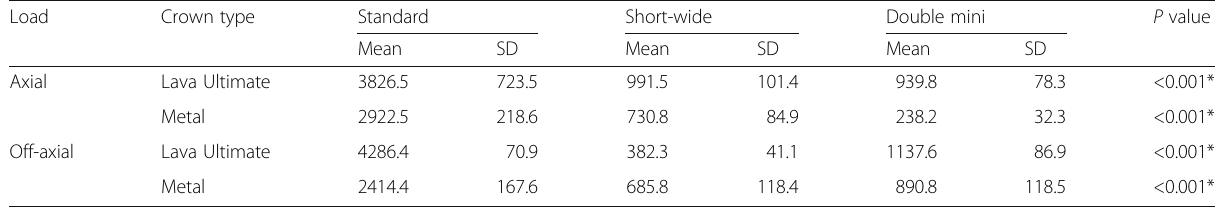
Table 2 Descriptive statistics and results of comparison between microstrains induced with different implant designs with each crown material (overall microstrains)